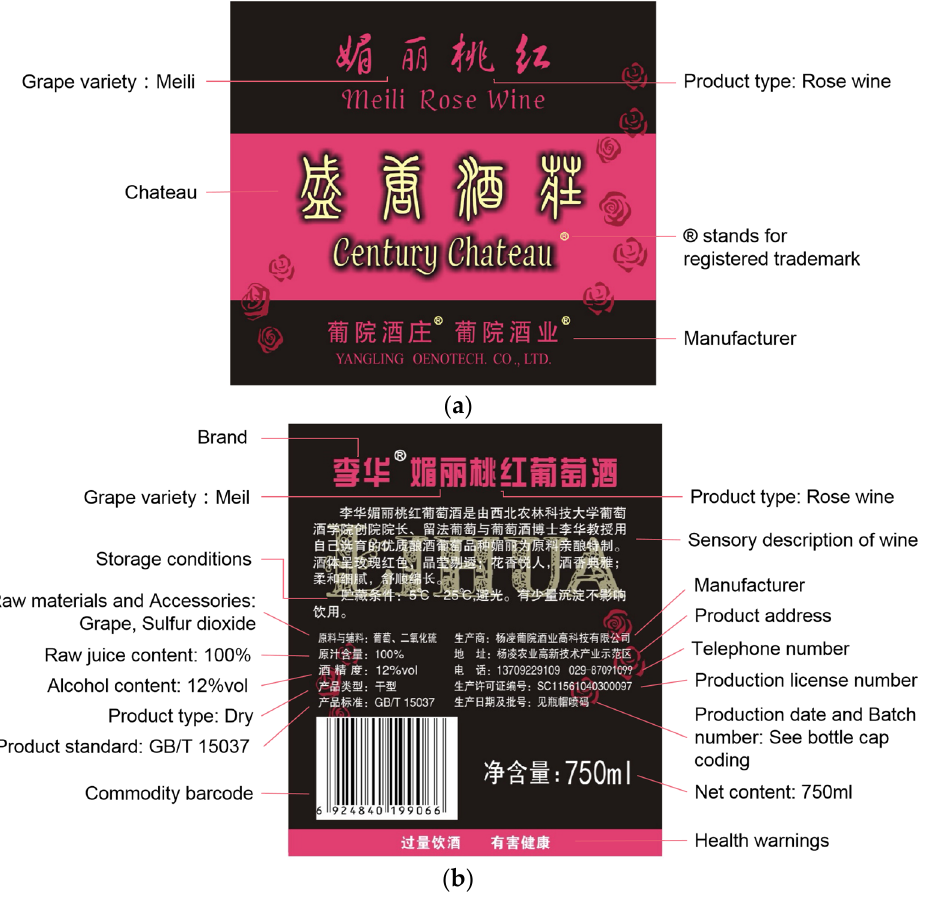
Figure 3. Explanation of information on a wine label in China. ( a ) Front label. ( b ) Back label. Table 5. National standards for net content and labeling of wine in China.